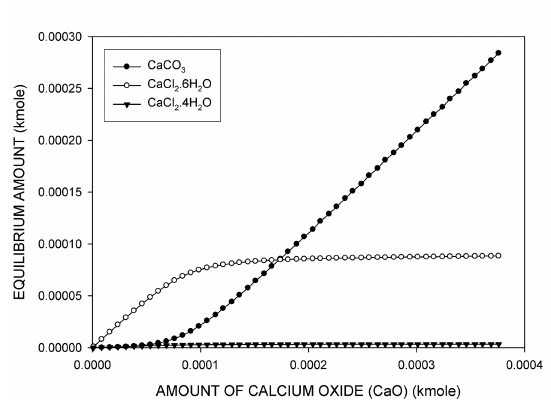
Effect of the amount of calcium oxide on the equilibrium amounts of the calcium-containing species for the Zn-Fe-Mn-O-H-C-Cl-Ca system in the absence of CaCO 3 and Ca(OH) 2